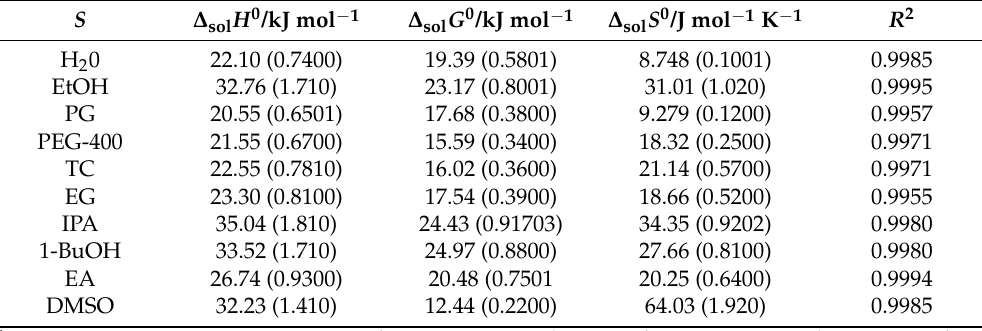
Table 4. Results of “apparent thermodynamic analysis” in terms of ∆ sol H 0 , ∆ sol G 0 , ∆ sol S 0 and R 2 values for TMZ in various solvents ( S ) b